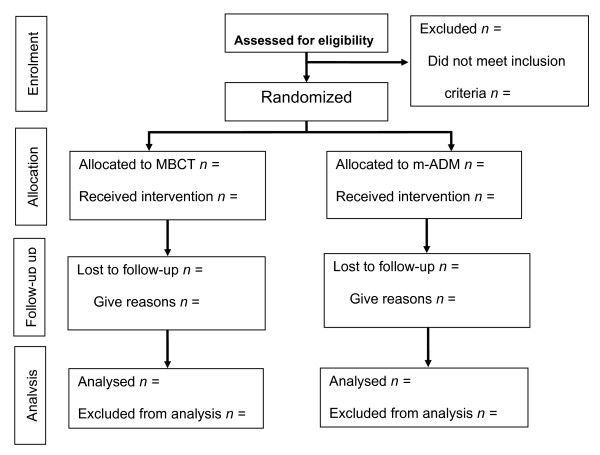
Consort diagram.